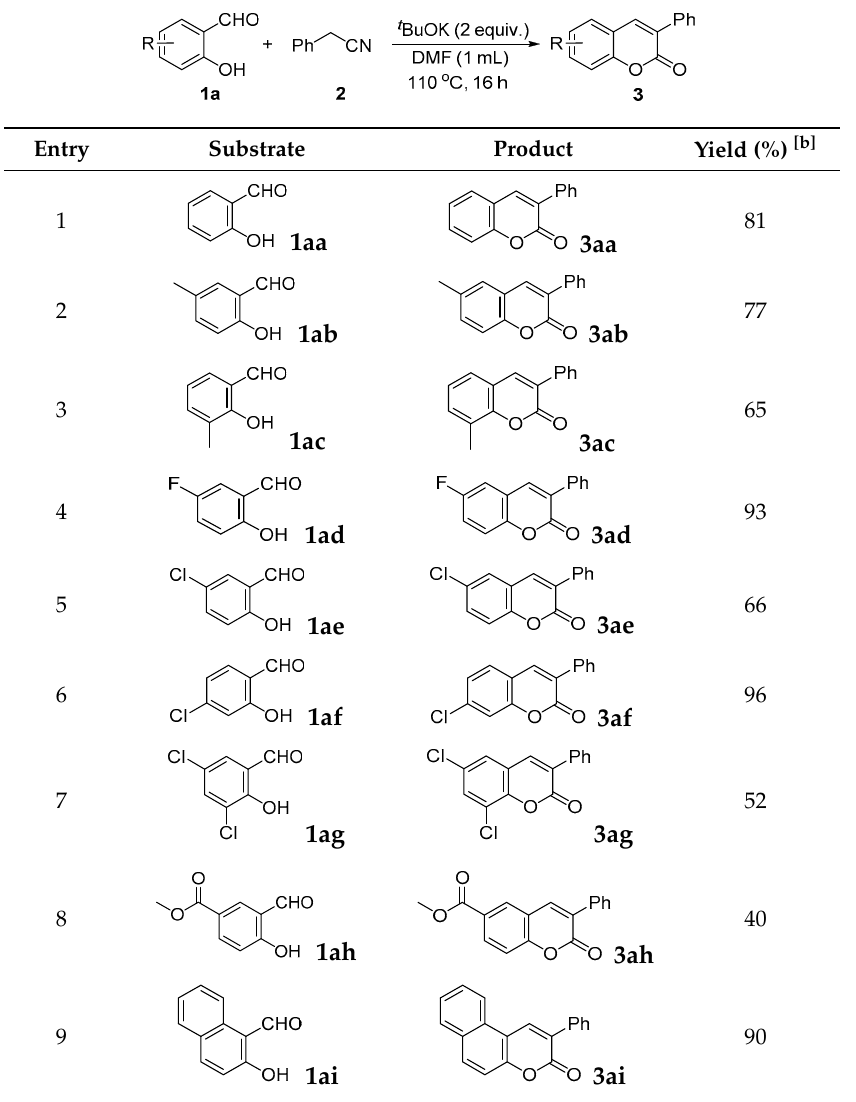
[a] . Table 2. Synthesis of chromenones from salicylaldehydes [a]